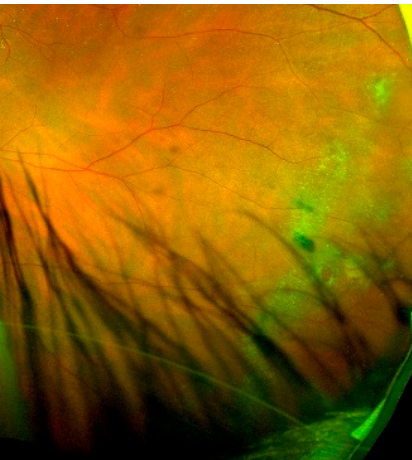
Figure 2. Color image of the fundus obtained using the ultra-wide field laser scanning ophthalmos- copy in a patient with ERM and exhibiting “snail track” lesions of the retina.